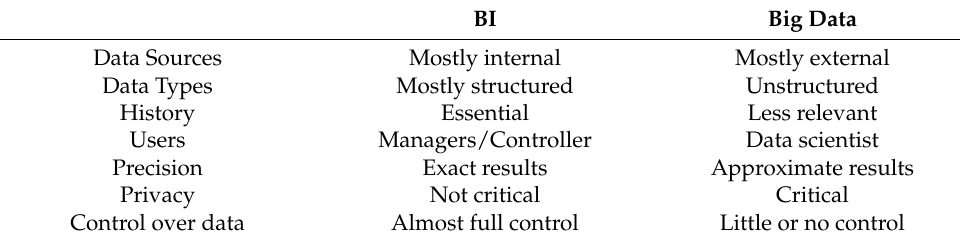
Table 1. Main differences between BI and big data.